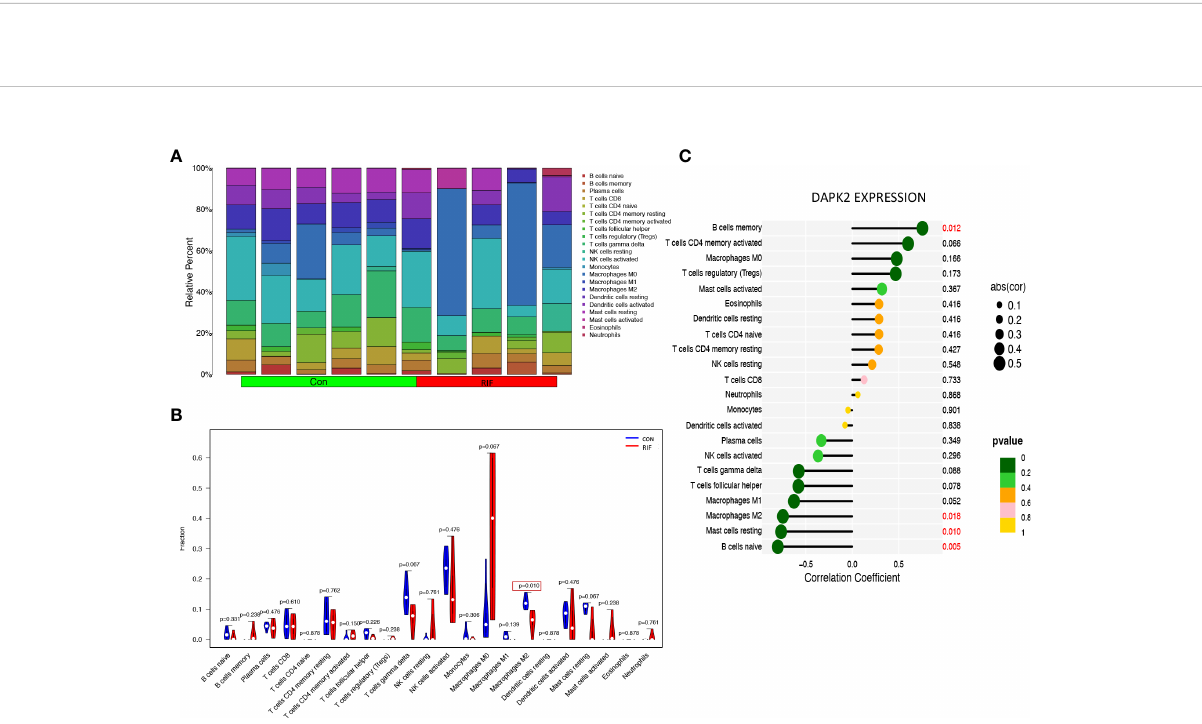
FIGURE 9 Immune cell in fi ltration analysis for RIF. (A) The proportion of 22 immune cells in RIF and controls. (B) The differential expression of 22 immune cells between RIF and controls. Blue was RIF group and red was control group. p < 0.05 was framed. (C) The relationship between DAPK2 expression and immune cells. p < 0.05 was